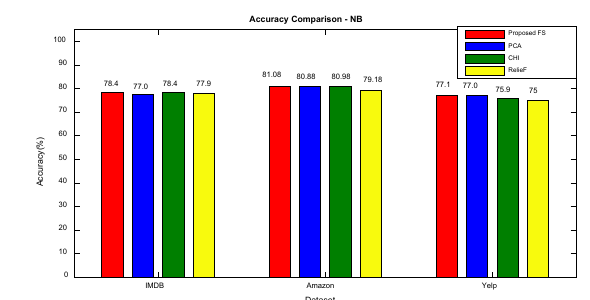
Figure 14. Accuracy comparison of ARM based feature selection with PCA, Chi Square and Relief on IMDB, Amazon and Yelp Review